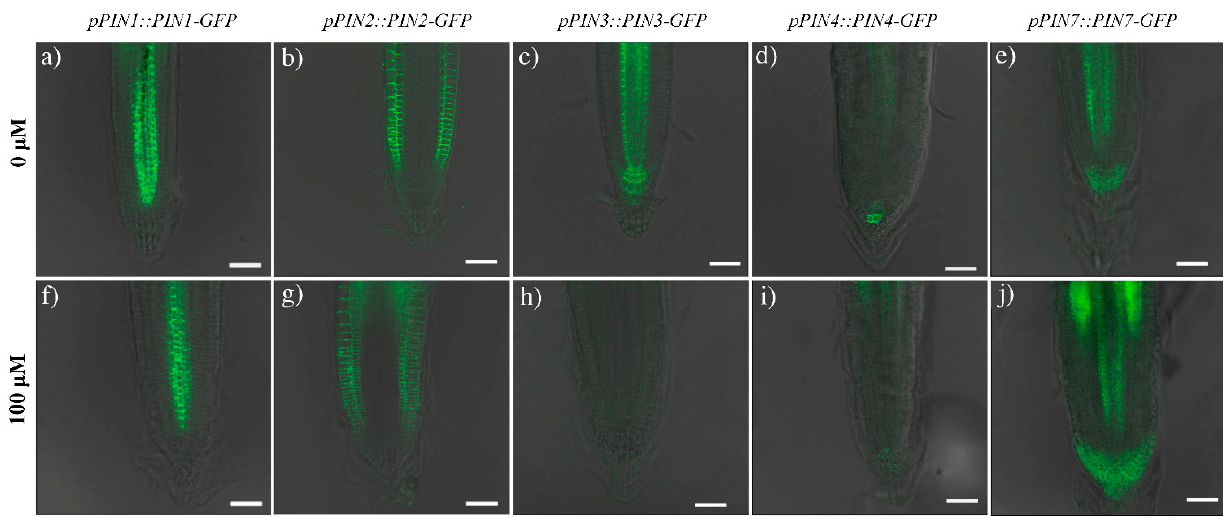
Figure 6. Images of the RAM in 4 days old seedlings of A. thaliana transgenic lines ( pPIN1::PIN1-GFP ( a , f ), pPIN2::PIN2-GFP ( b , g ), pPIN3::PIN3-GFP ( c , h ), pPIN4::PIN4-GFP ( d , i ), pPIN7::PIN7-GFP ( e , j )) treated for 48 h with coumarin 0 ( a – e ) or 100 µM ( f – j ). Scale bars 30 µm. N = 20.